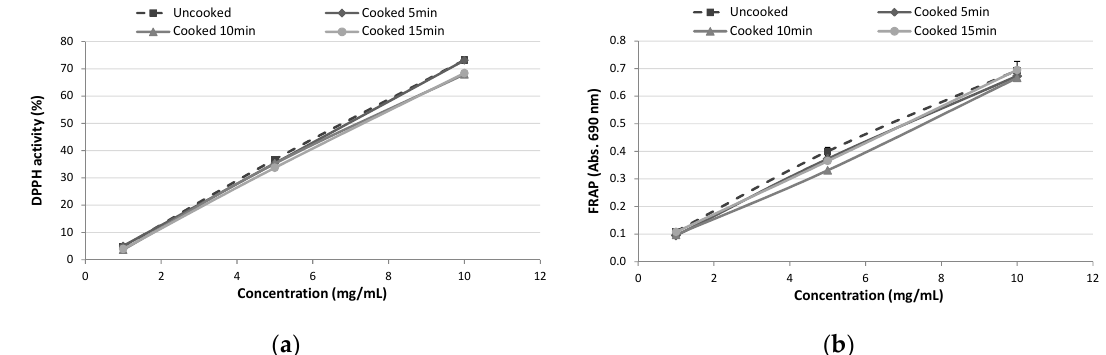
Figure 2. Antioxidant activity determined by ( a ) DPPH radical scavenging activity and ( b ) ferric reducing antioxidant power (FRAP) of tomato by-products hydrolysates before and after cooking at 70 °C (5, 10, and 15 min).